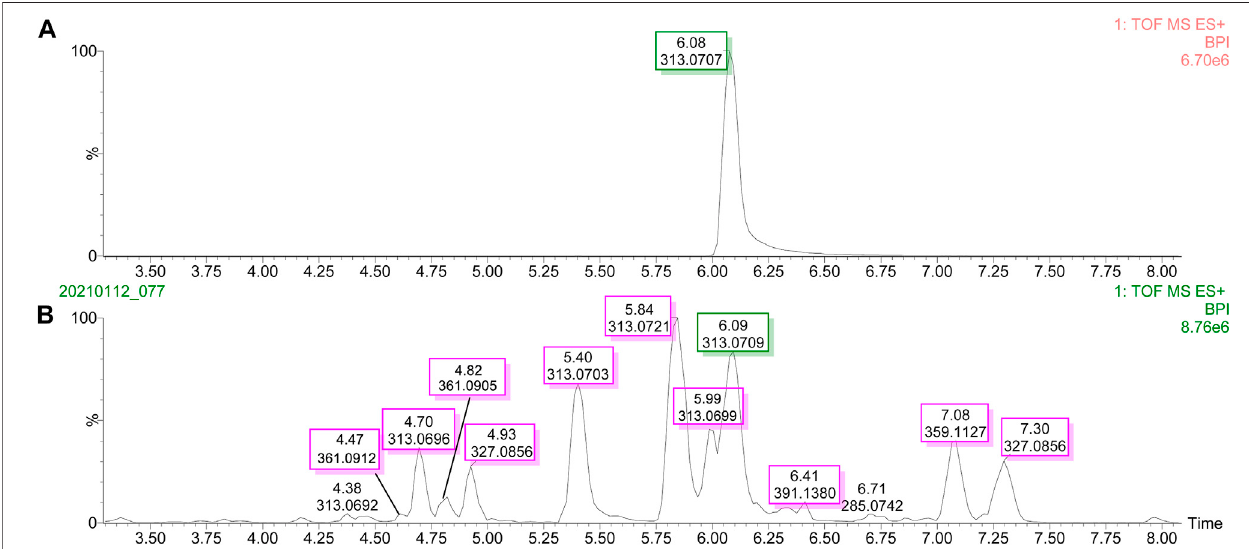
FIGURE 1 | UPLC-Q-TOF-MS/MS pro fi les of the degradation products of a fl atoxin B 1 in methanol solvent. (A) Base peak intensity (BPI) of a fl atoxin B 1 . (B) Base peak intensity (BPI) of degradation products of a fl atoxin B 1 .